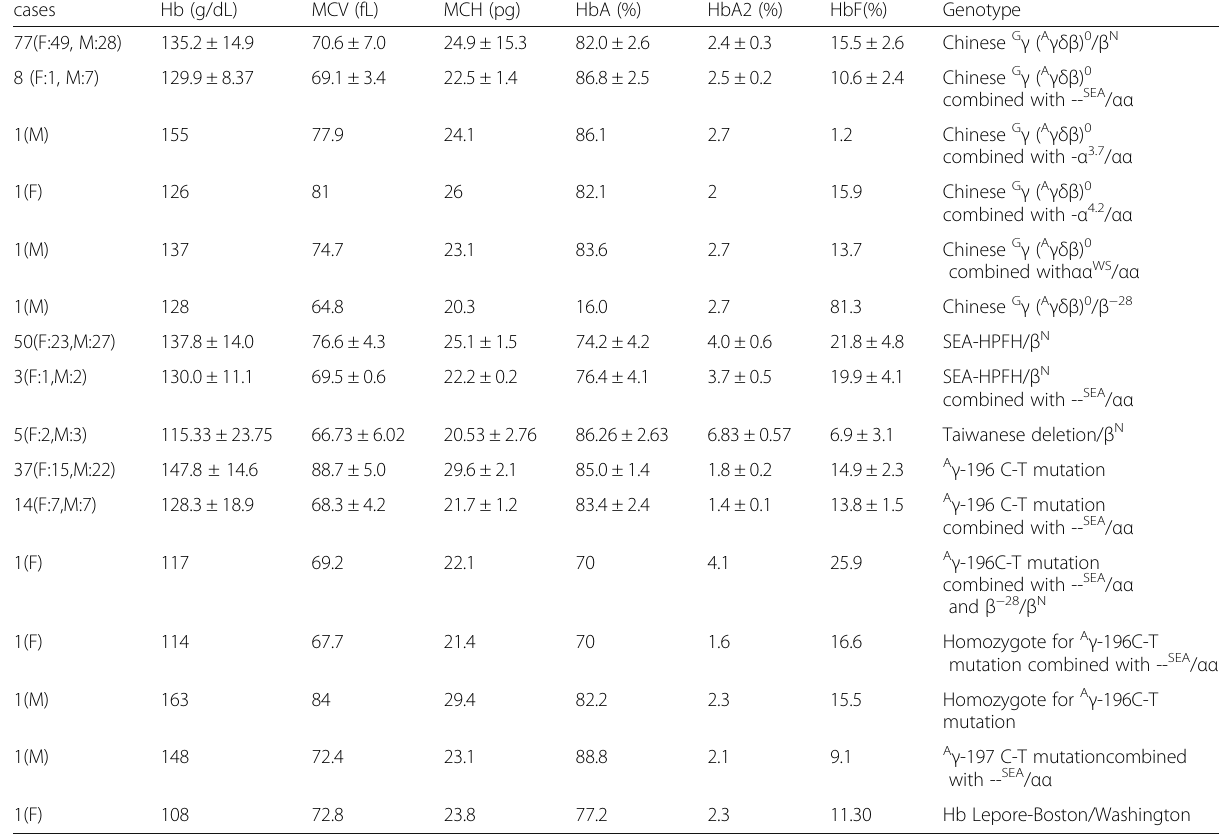
( − - SEA / αα ) and A γ -196C-T mutation. The hematological data are shown in Fig. 4. For the first time, we describe two homozygous carriers of the A γ -196 C-T mutation and one with coexistence of α 0 β -thal and the A γ -196C-T mutation. (Fig. 5a). Another nondeletional HPFH variant named Cre- tan HPFH ( A γ -197 C-T mutation) was detected for the first time in China as well. This individual was also a carrier of the Southeast Asia deletional type ( − - SEA / αα ) (Fig. 5b). The hematological analysis showed high HbF levels and Table 2 The hematological datas of individuals with the main genotype shown in Fig.